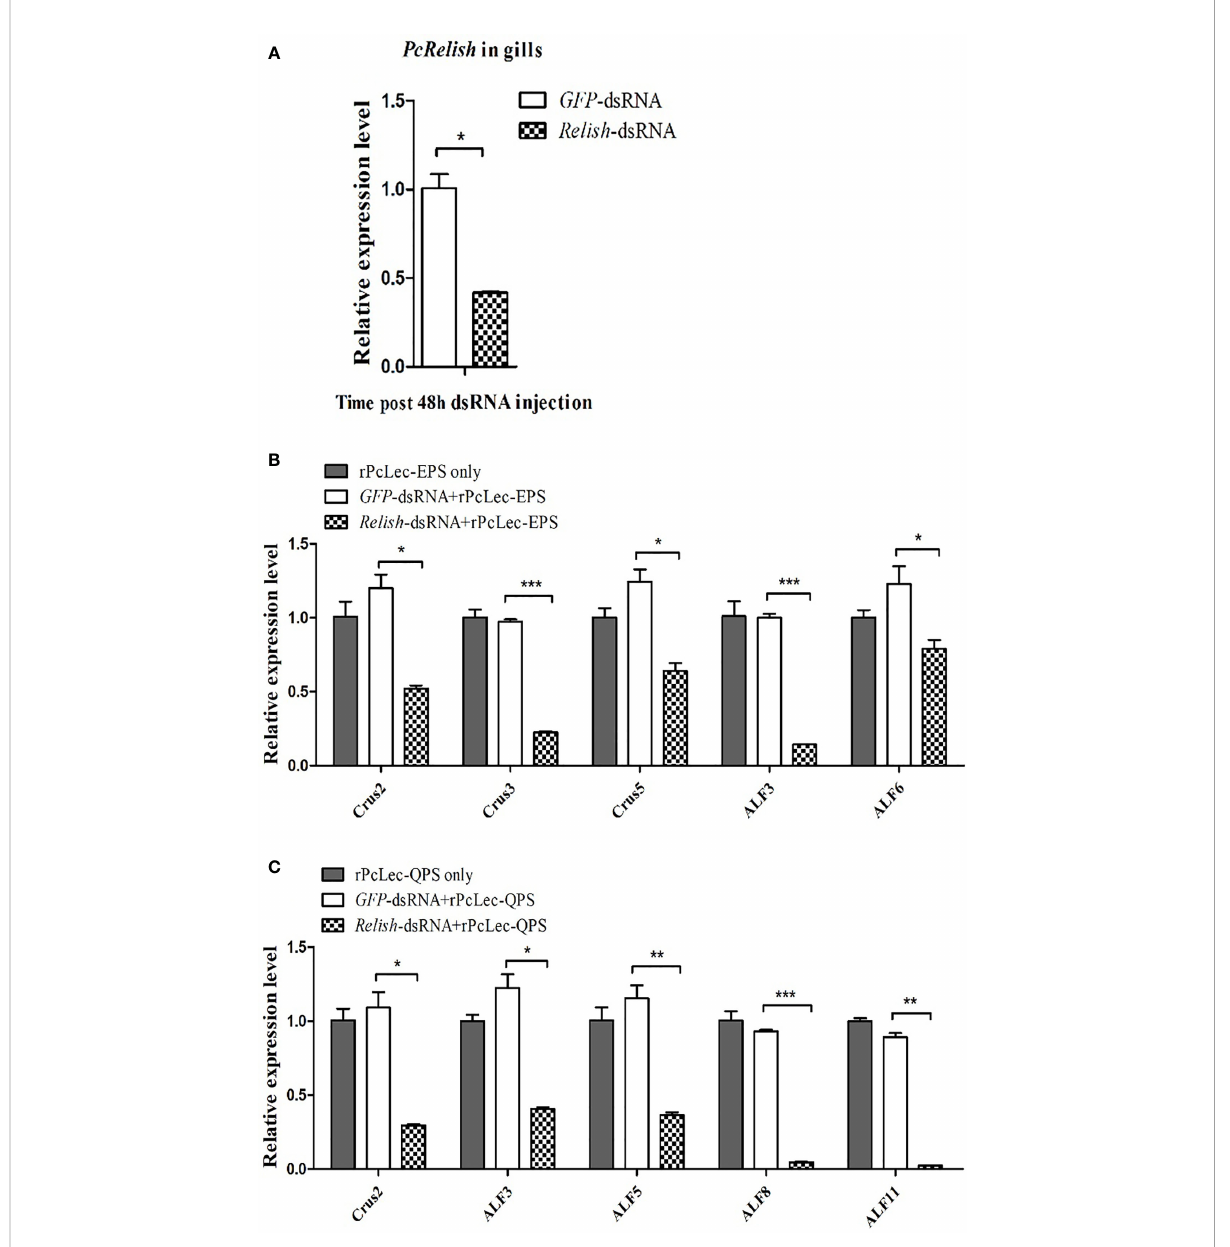
FIGURE 8 Analysis of AMPs expression regulation after recombinant CTL (rPcLec-EPS or rPcLec-QPS) injection in the Relish transcriptional factor knockdown cray fi shes. (A) The expression level of PcRelish in the gills at 48 h after PcRelish- dsRNA injection was measured by RT-qPCR. Sample from GFP- dsRNA injected cray fi shes was used as control. (B) Detection of the expression levels of AMPs ( Crus2 , Crus3 , Crus5 , ALF3 , and ALF6 ) at 24 h after rPcLec-EPS injection in the gills of Relish knockdown cray fi shes. rPcLec-EPS only and GFP- dsRNA plus rPcLec-EPS were used as controls. (C) Detection of the transcriptional levels of AMPs ( Crus2 , ALF3 , ALF5 , ALF8 , and ALF11 ) at 24 h after rPcLec-QPS injection in the gills of Relish knockdown cray fi shes. rPcLec-QPS only and GFP- dsRNA plus rPcLec-QPS were used as controls. Data are presented as mean ± SD, N=5. Asterisks indicate signi fi cant differences between experimental group and control group (* p < 0.05, ** p < 0.01, and *** p <